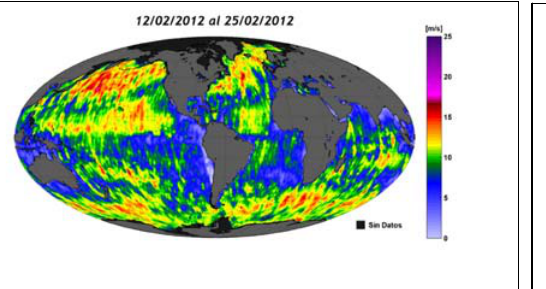
Figure. 4: Global Wind Speed Map from MWR.